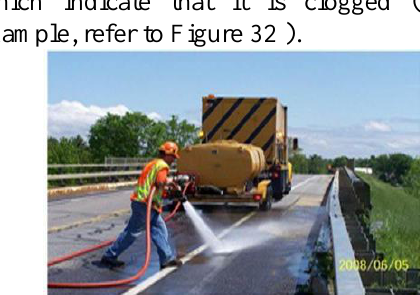
Figure 29. Comparison of predicted temperature and humidity values in node 2 with actual logged values.